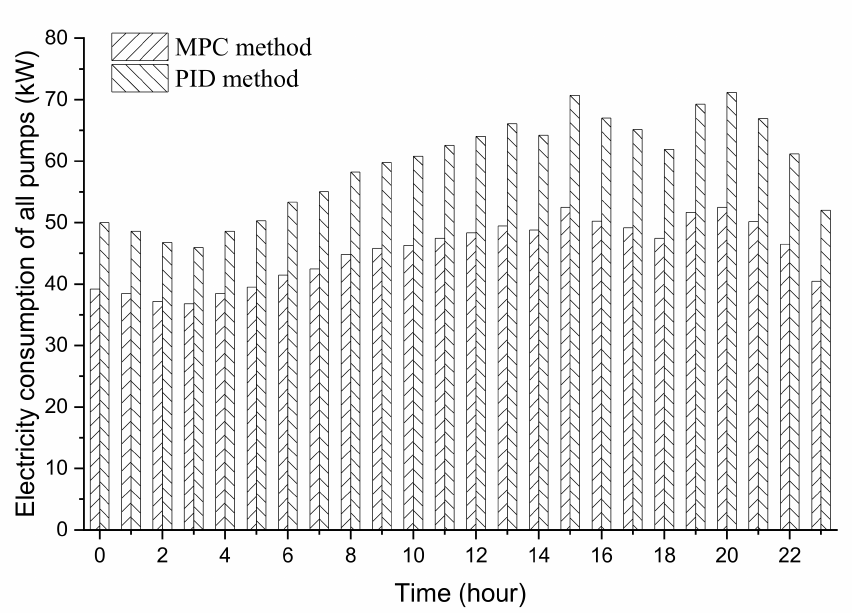
Figure 14. The hourly simulation results by the MPC method and the PID